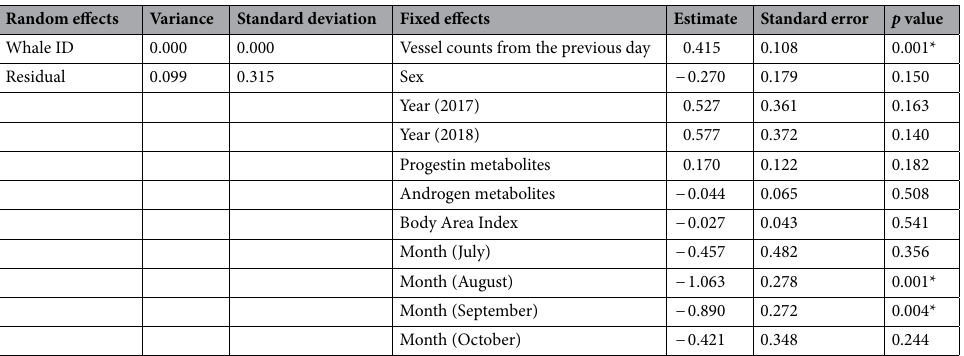
Table 2. Parameter estimates from the chosen generalized linear mixed model (model 2) for gray whale fecal glucocorticoid metabolite concentrations using vessel counts from the previous day, sex, month, year, progestin metabolites, androgen metabolites, and body condition (Body Area Index: BAI) as fixed effects and whale identification as random factor. *Significance ( p <